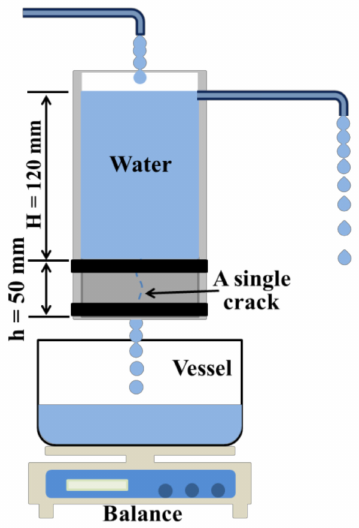
Figure 2. Schematic diagram of water permeability